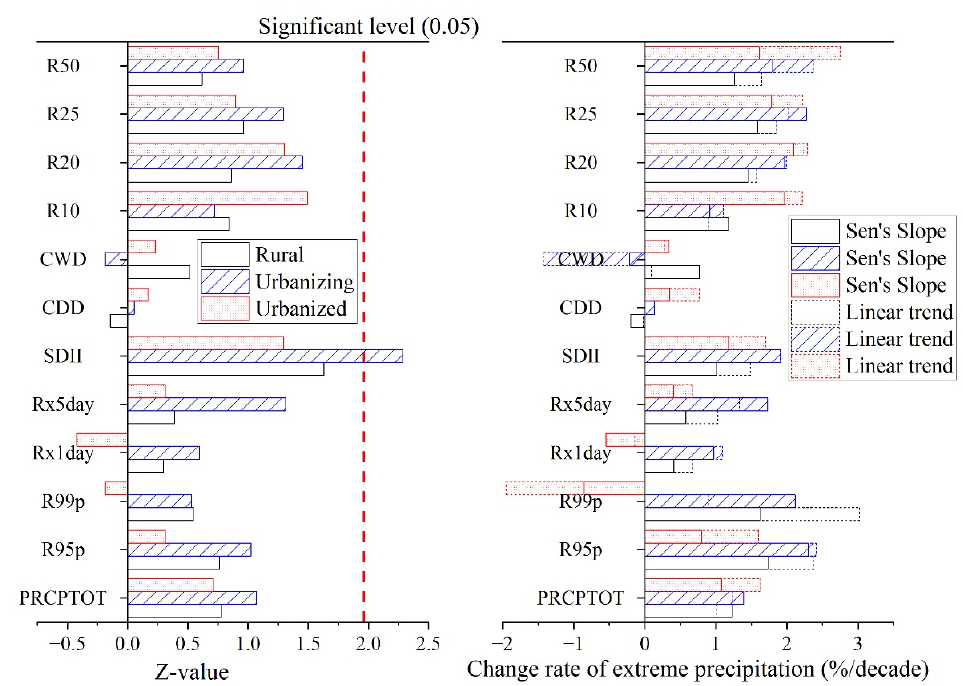
Figure 3. Trends of extreme precipitation series for rural, urbanizing, and urbanized areas with different methods.